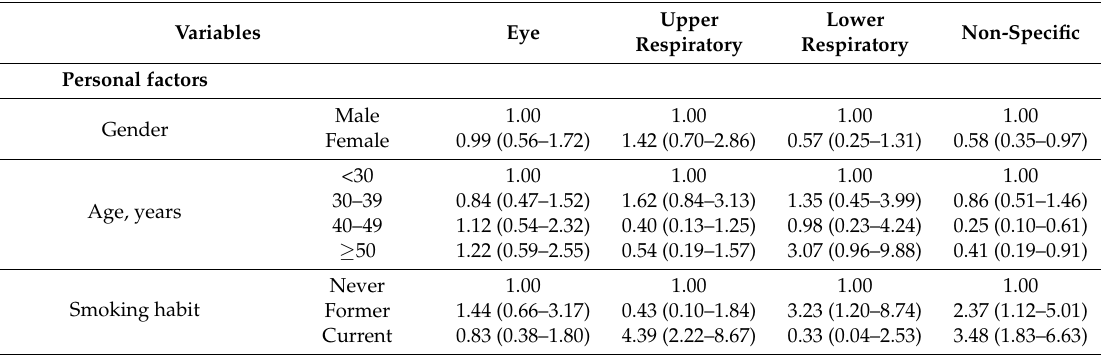
Table 2. Crude odds ratios of sick building syndrome symptoms in relation to personal, psychosocial, and environmental factors ( n =